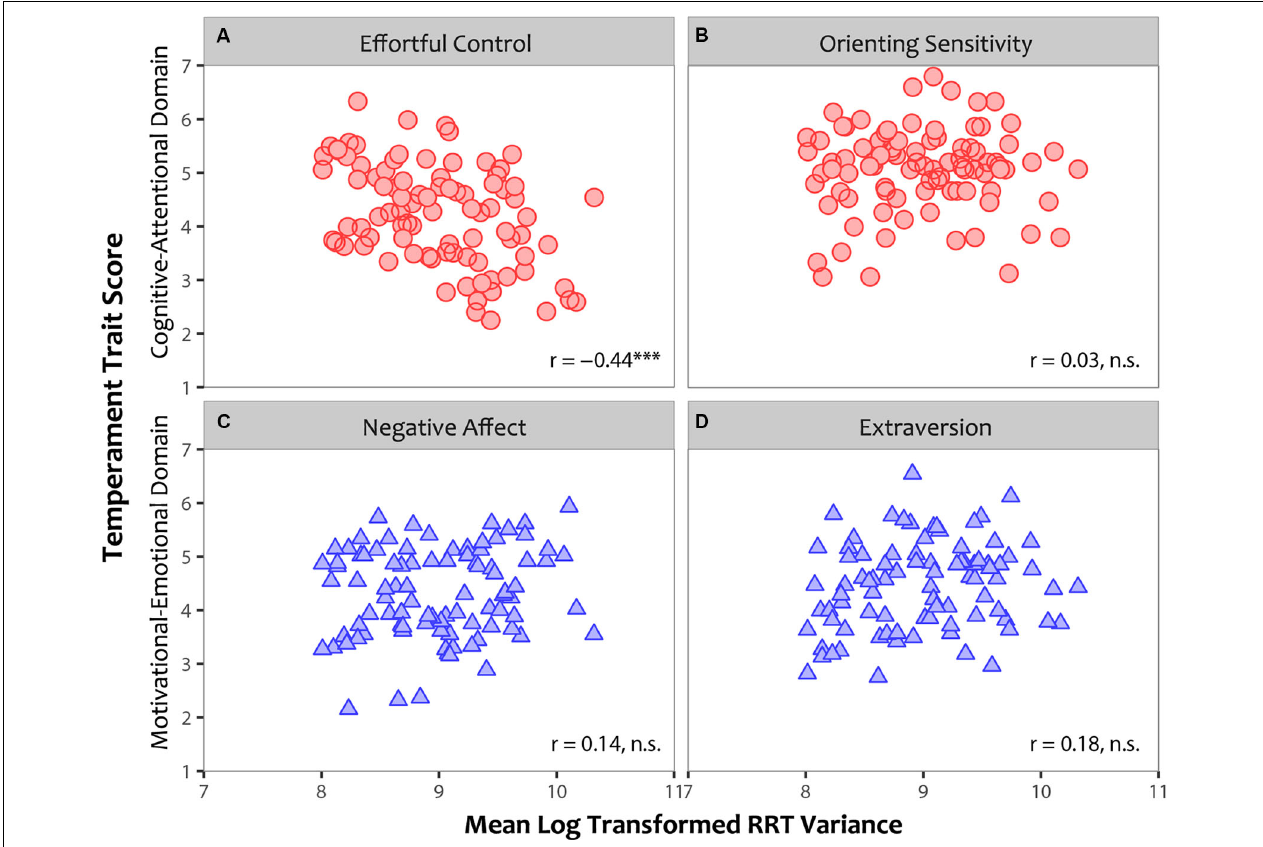
FIGURE 4 | The relationship between individual participants’ mean log transformed variance in rhythmic response time (RRT) for the visual metronome response task (vMRT; x-axis) and their temperament traits as assessed by the Adult Temperament Questionnaire (ATQ; y-axis). Cognitive-Attentional axes are depicted as red circles and Motivational-Emotional as blue triangles. Significant relationships are indicated as follows: * p < 0.05; ** p < 0.01; *** p < 0.001.